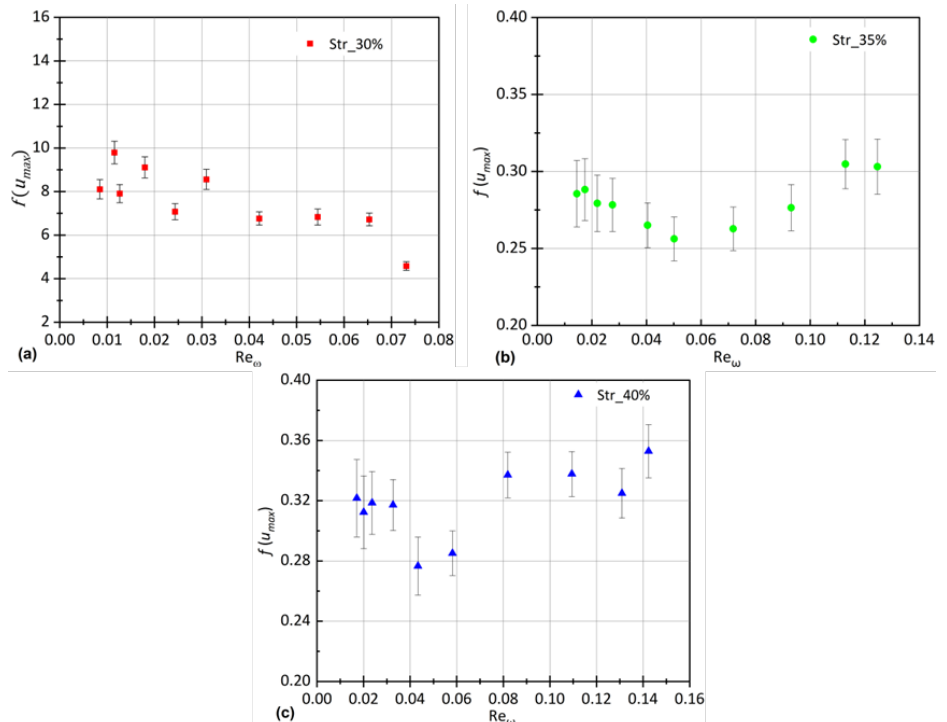
Figure 11. Evolution of friction factor at maximum velocity of regenerator (( a ): Str_30%, ( b ): Str_35%, ( c ): Str_40%. L 1 = 60 mm, C 1 = 64.4 mm) versus kinetic Reynolds number Re ω